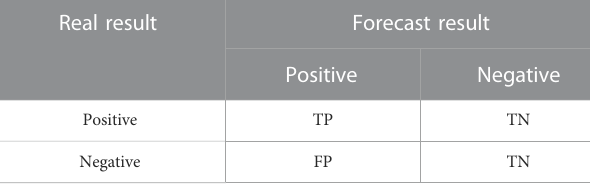
TABLE 2 Confusion matrix classi fi cation table. Real